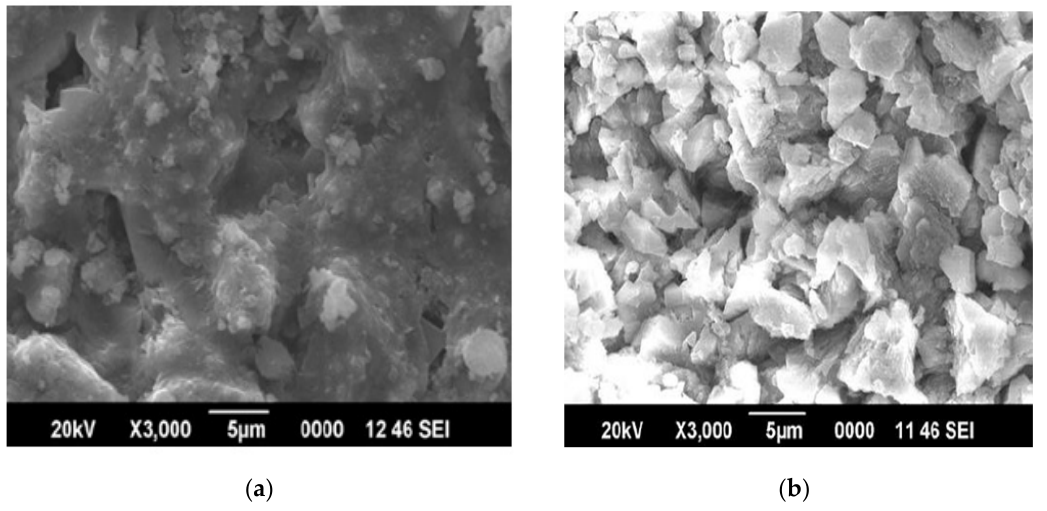
Figure 7. ( a ) Conventional concrete, ( b ) self-curing